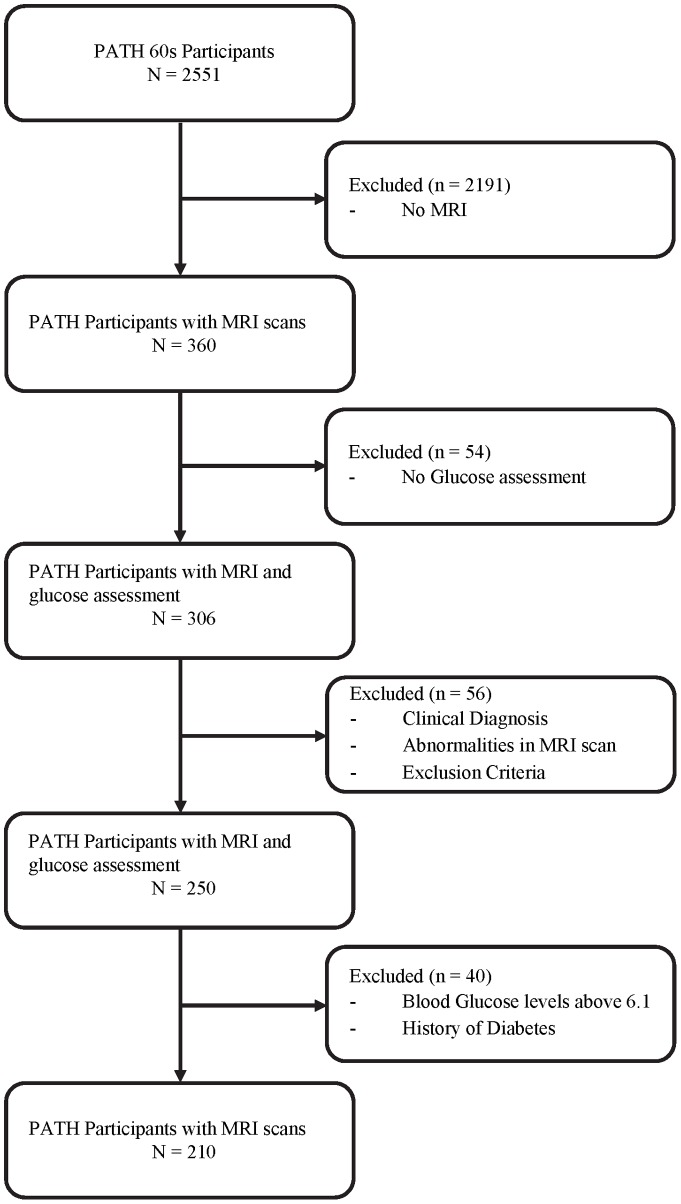
Sample Inclusion.